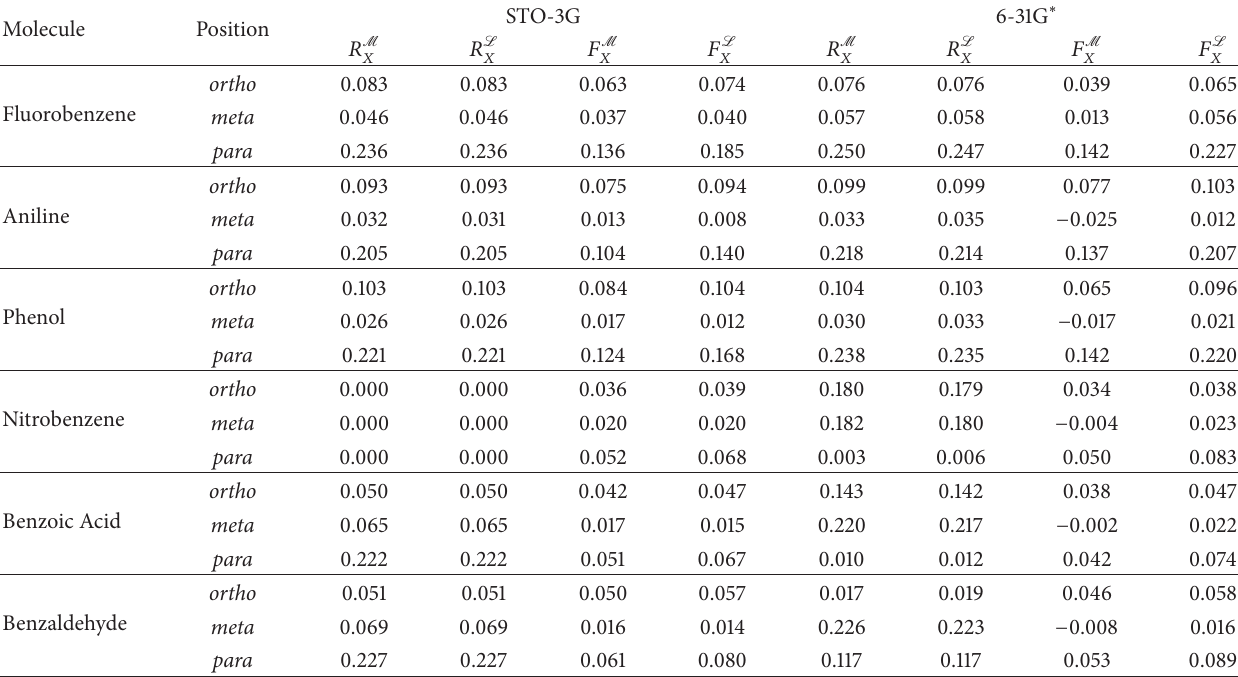
Table 1: Atomic indices of nucleophilicity (13) and condensed atomic Fukui indices (14) for selected benzene derivatives. For asymmetric species, the position refers to carbon atom with larger electron population. Methods: RHF/ROHF, basis sets: STO-3G, 6-31G ∗ . Molecule